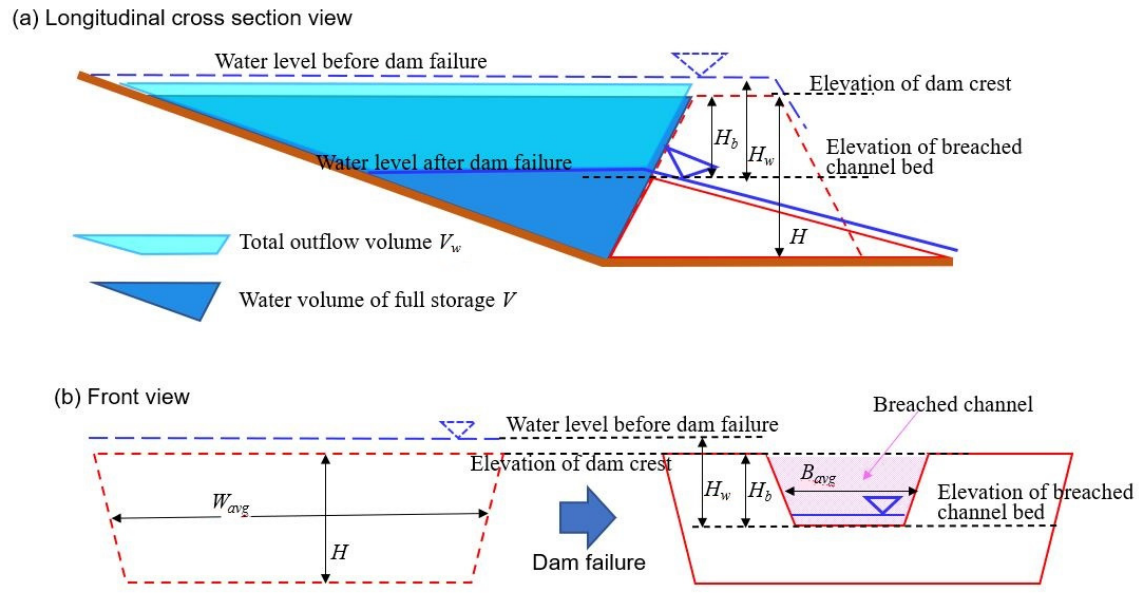
Figure 6. Schematic illustration of the dam breaching parameters ( a ) H b , H w , H , V w and V in longitudinal view ( b ) W avg and B avg in Front view.